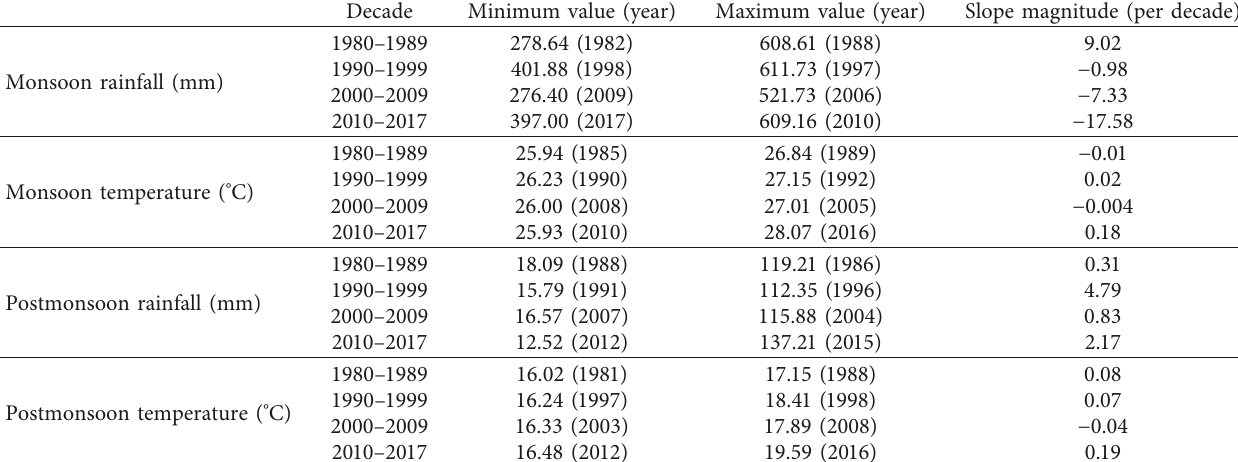
Table 2: Decadal changes in monsoon rainfall and seasonal mean temperature in northern monsoon belt of Pakistan during the time period of 1980–2017.